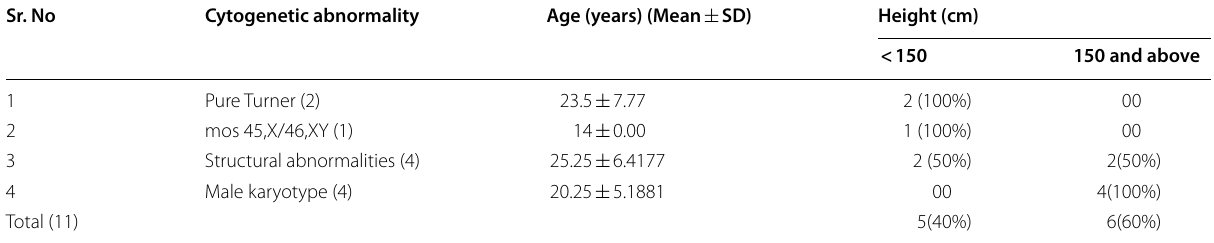
Table 2 Distribution of cytogenetic abnormality, age and height in primary amenorrhoea cases Sr.